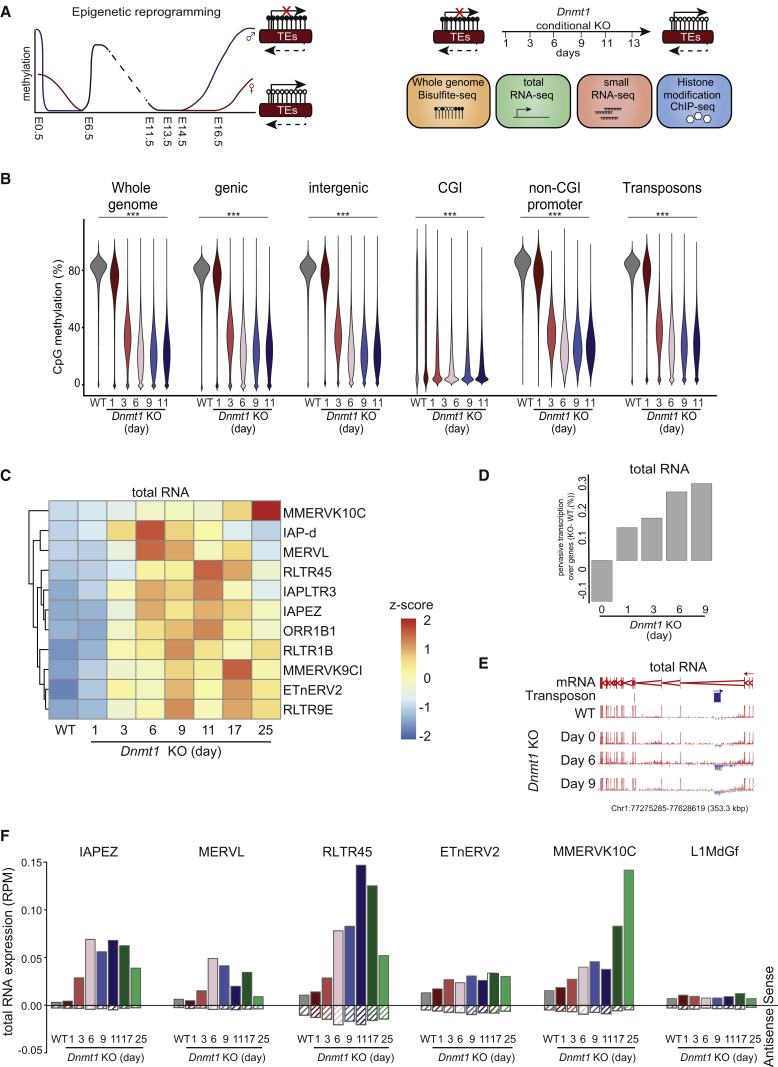
Transcriptional Upregulation of Specific TE Classes upon Acute Dnmt1 Deletion(A) Left: schematic overview of epigenetic reprogramming during preimplantation and male (blue) and female (red) germline development. Right: schematic of Dnmt1 cKO as an in vitro system for mechanistic study of TE regulation during epigenetic reprogramming.(B) Violin plots showing the distribution of CpG methylation levels measured by WGBS-seq of WT (gray) and conditional Dnmt1 cKO ESCs induced for days depicted in the figure. The percentage of methylated cytosines was quantified in consecutive 50 CpG windows genome-wide. CGI, CpG island. For significance analysis, Wilcoxon rank-sum test with Bonferroni correction testing with a p value threshold of <0.05.(C) Heatmap of unbiased hierarchical clustering of all TEs responsive to Dnmt1 cKO across the time course of KO induction. The relative expression (Z score) of TEs upon Dnmt1 cKO is shown; n = 2.(D) Bar graph showing the percentage of genic antisense transcription upon Dnmt1 deletion in KO relative to WT samples; n = 2.(E) Chromosome view of TE inserted antisense to gene. Position of TE is denoted (top panel) along with sense strand-specific RNA-seq reads (lower panels; sense transcription shown in blue; antisense transcription shown in red). Each read is depicted. Arrows indicate directionality of reads.(F) Expression of TEs in conditional Dnmt1 cKO ESC. Shown are normalized RNA-seq read counts overlapping different TE classes in sense (filled bars) or antisense (hatched bars) orientation. The figure shows mean of n = 2.See also Figures S1 and S4I and Data S1.